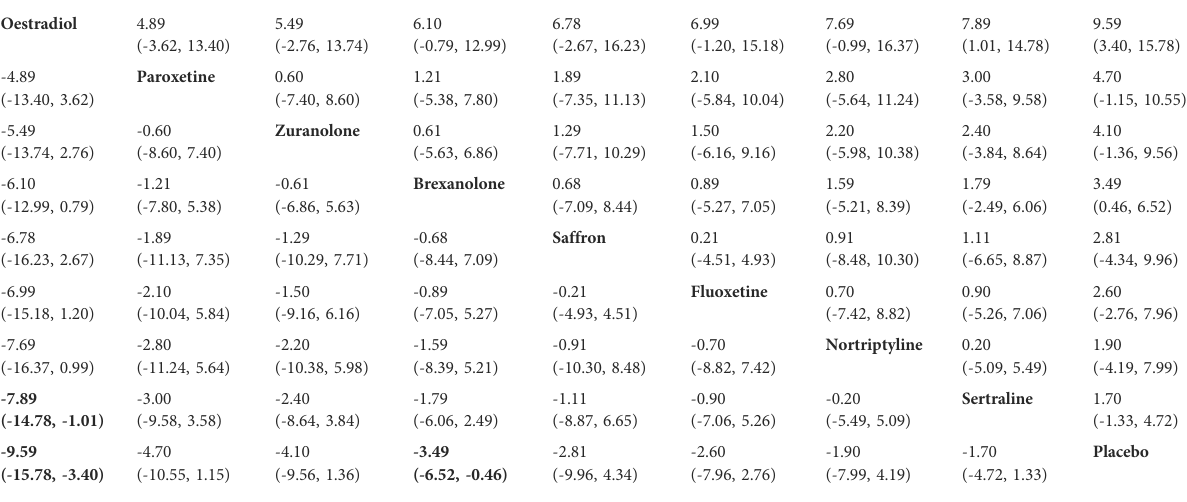
TABLE 2 Network meta-analysis results of the ef fi